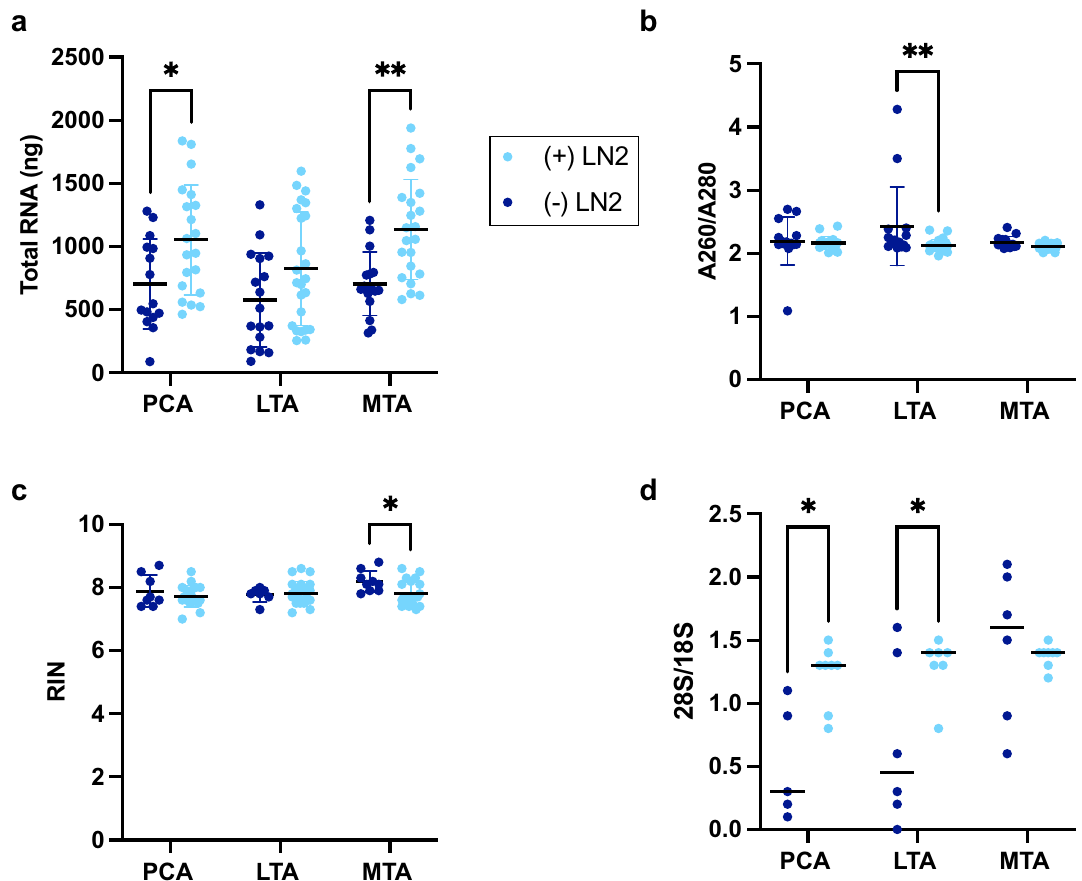
Figure 5. The influence of adapted cryogenic disruption on total RNA recovery under experimental (+LN2) and standard conditions (−LN2). Data points plotted in dark blue signify standard conditions, or samples processed without liquid nitrogen (PCA, N = 15; LTA, N = 17; MTA, N = 16), while the light blue denotes experimental conditions, or the samples that were processed with liquid nitrogen (PCA, N = 20; LTA, N = 24; MTA, N = 22). The vertical lines associated with the respective colors represent the error, while the horizontal lines (dark black) indicate the mean. ( a ) Comparison of total nucleic acid extraction, determined by Nanodrop Spectrophotometer at 260 nm, under the experimental and standard conditions. ( b ) Changes in A 260 /A 280, measured via Nanodrop, under experimental and standard conditions. ( c ) The impact of the RIN, provided by the Agilent 2100 Bioanalyzer Pico chip, due to cryogenic disruption under experimental and standard conditions. ( d ) Analysis of the tendencies of the 28S/18S ratios under experimental and standard conditions. Analysis of variance was performed using a two-way ANOVA with Posthoc tests. The data is expressed as mean ± SD. * means P < 0.05; ** P < 0.01; *** P < 0.001; **** P <